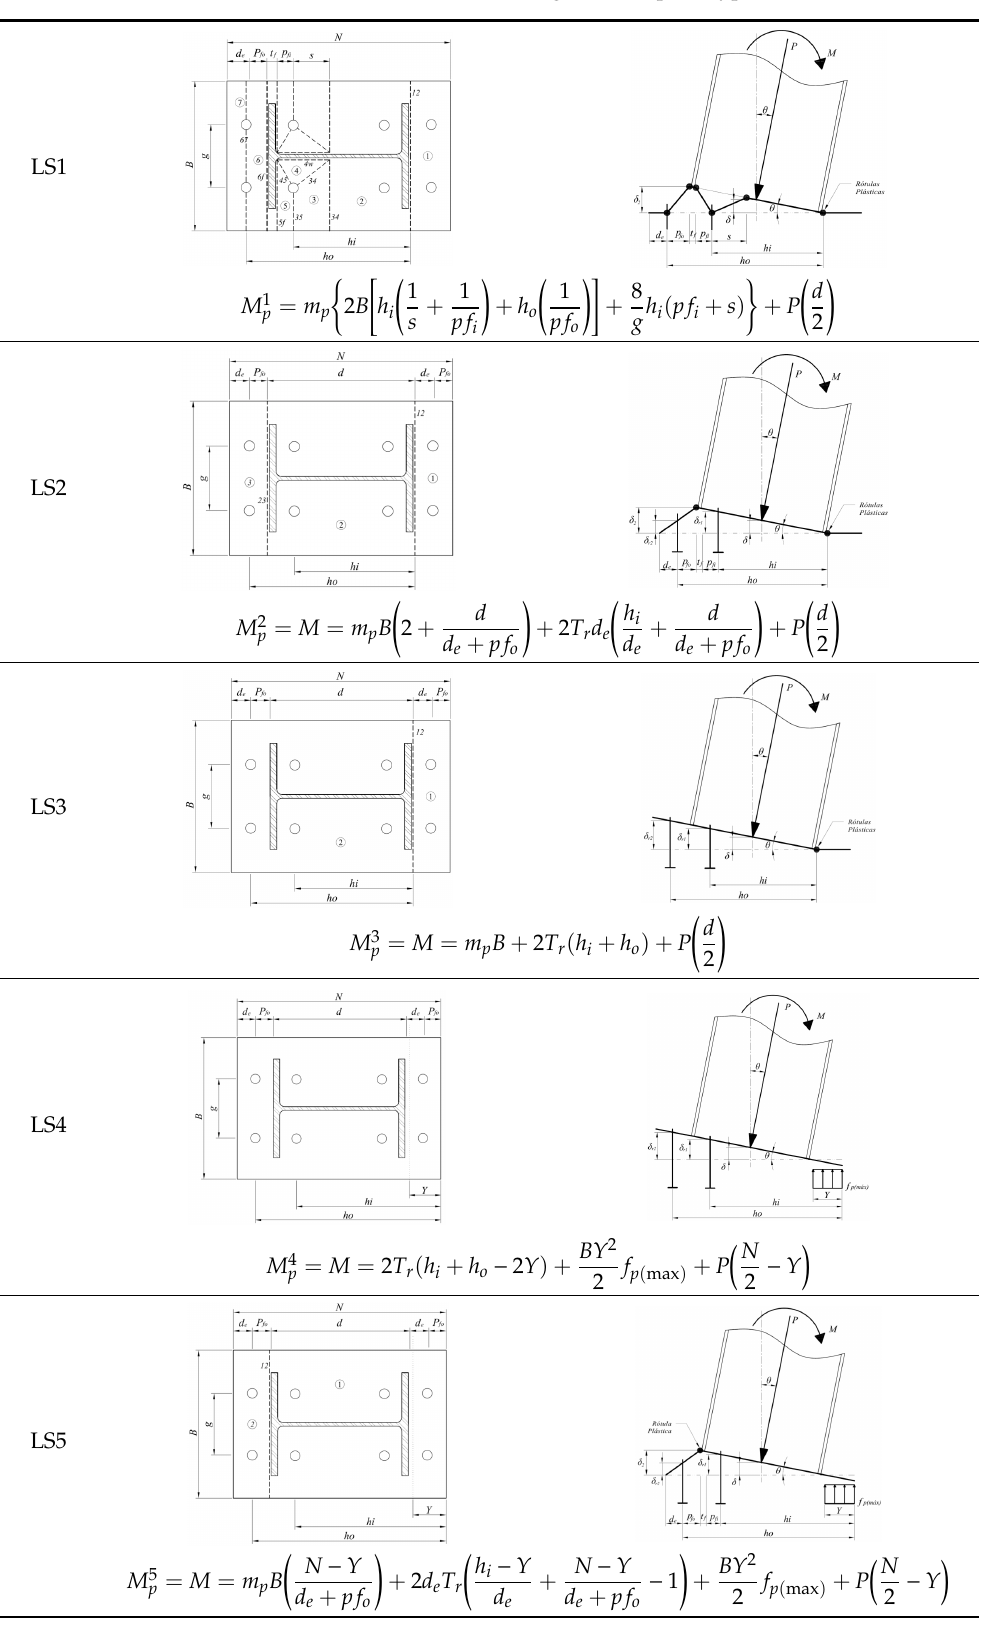
Table 4. Limit states that control the design of base plate type SBP-1.